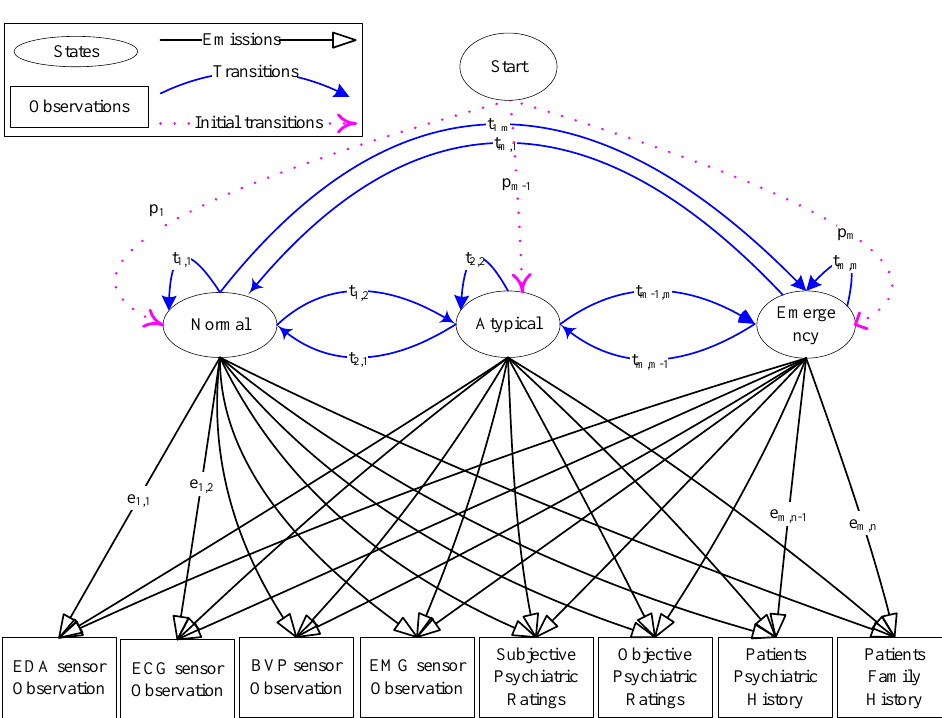
Figure 6. Hidden Markov model-based psychiatric state model for predicting an emergency psychiatric state in the AAL